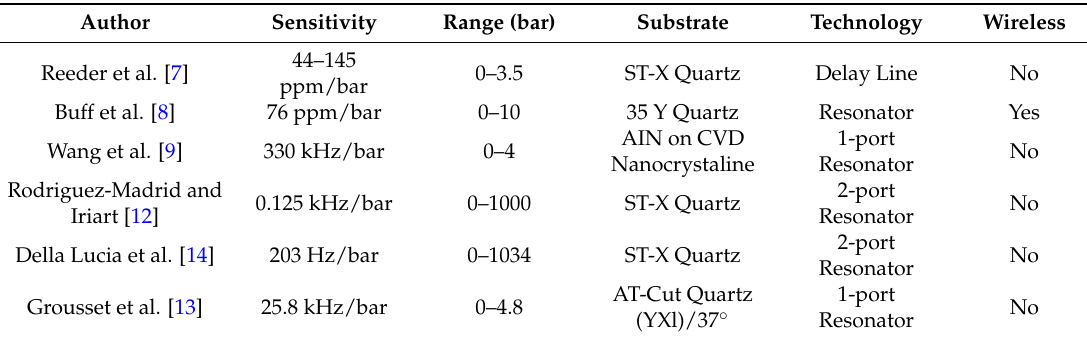
Table 1. Summary of the main parameters related to pressure sensors based on surface acoustic wave (SAW)